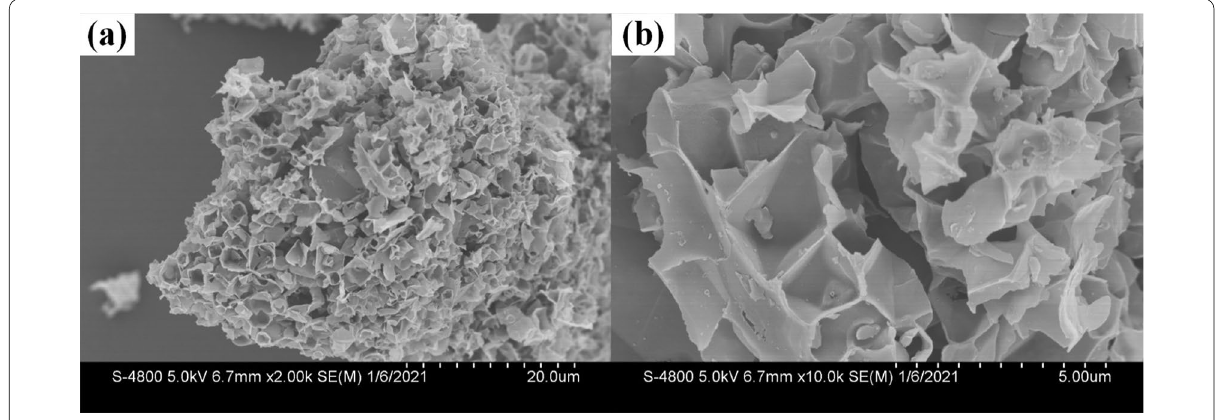
Fig. 1 SEM images of three-dimensional graphene: a 20 μm; b 5